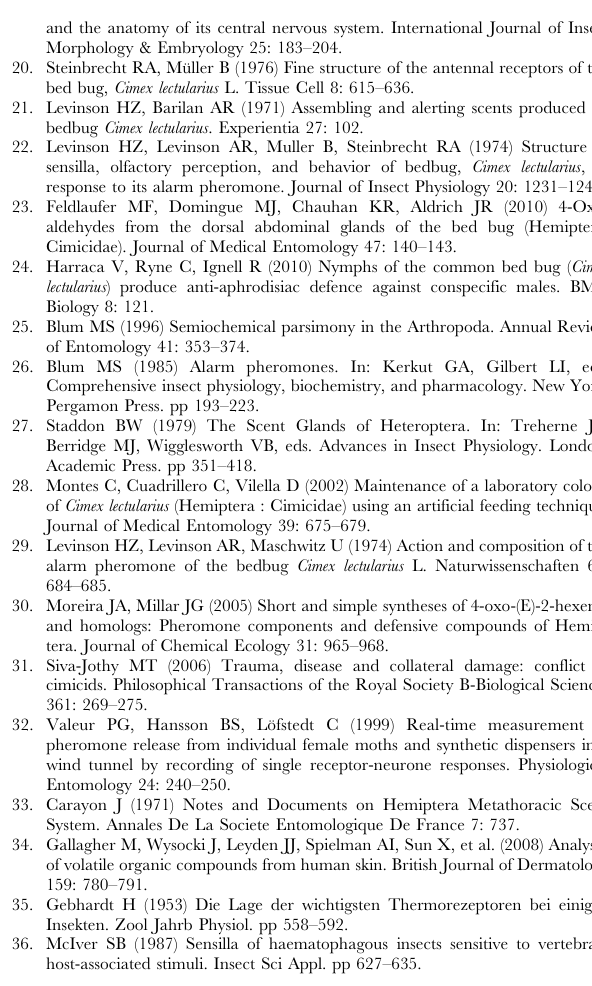
Figure S1 Infrared spectra of natural and synthetic odour components. Infrared spectra of ( E )-2-hexenal, ( E )-2- octenal, 4-oxo-( E )-2-hexenal and 4-oxo-( E )-2-octenal from C. lectularius extracts and synthetic reference compounds. Gas Chromatography-Fourier transform infrared spectroscopy (GC- FTIR) analyses were carried out on extracts and reference